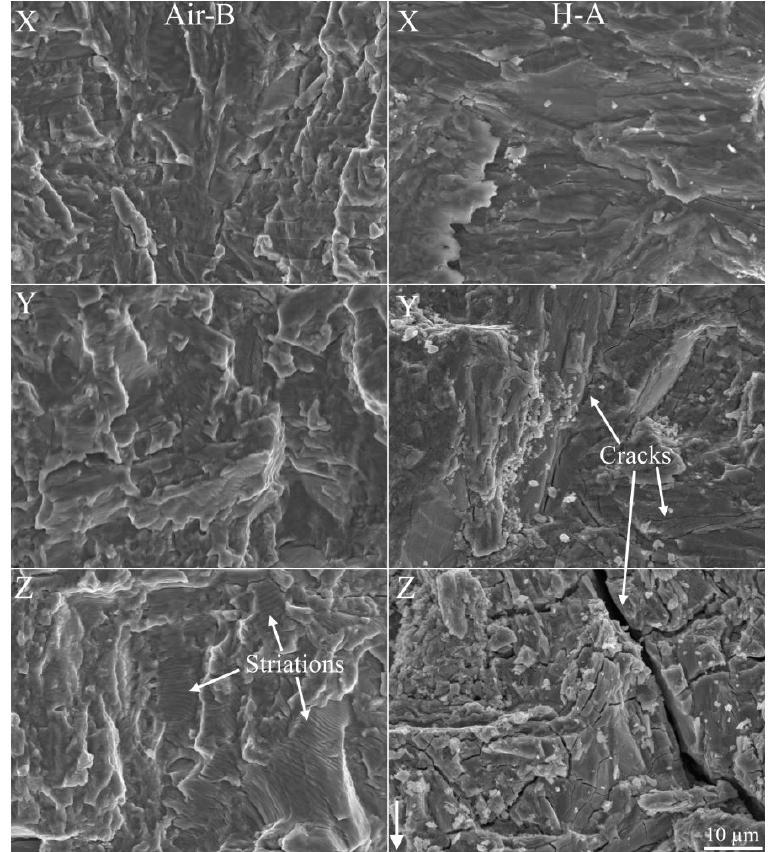
Figure 9. Images of the three sections X-Z (see Figure 6 for locations of the areas on the fracture surface) for one air (sample Air-B) and one hydrogen (sample H-A) tested sample. The images are in the same magnification and the white arrow in the bottom right indicates the crack propagation direction. In section Z of Air-B, examples of striations are indicated with the white arrows. In sections Y and Z of H-A, white arrows point at cracks; their dimensions increase from the former section to the